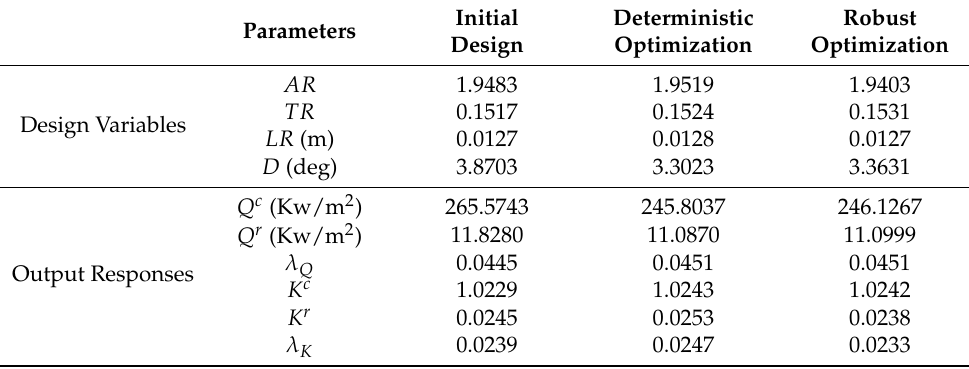
Table 3. Comparisons of the three aerodynamic shapes for the hypersonic wing.